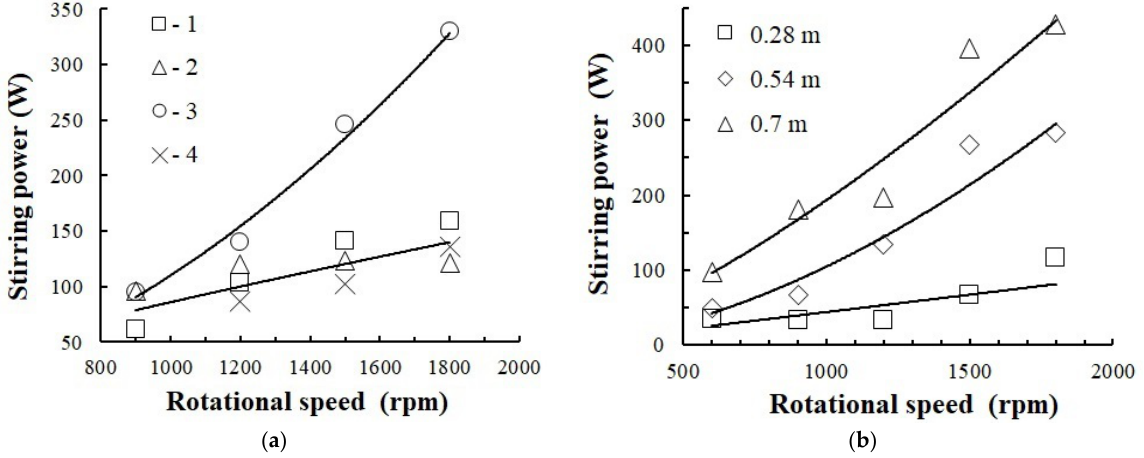
Figure 13. Dependence of the mixing power on the rotational speed: ( a ) H L / D = 1.2, D = 0.280 (m), d s = 0.064 (m) with variation in the number of partitions: 1—one partition, h = 0.3 (m); 2—two partitions, h = 0.3 (m); 3—three partitions, h = 0.3 (m); 4—one partition, h = 0.05 (m); ( b ) D = 0.280 (m), one partition, d s = 0.075 (m), h = H L with varying liquid column height H L .